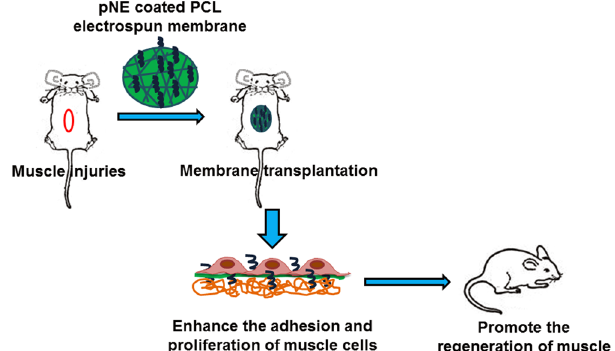
Figure 1. Scheme of pNE coated PCL electrospun fibrous membranes and their effect on muscle regeneration in vitro and in vivo